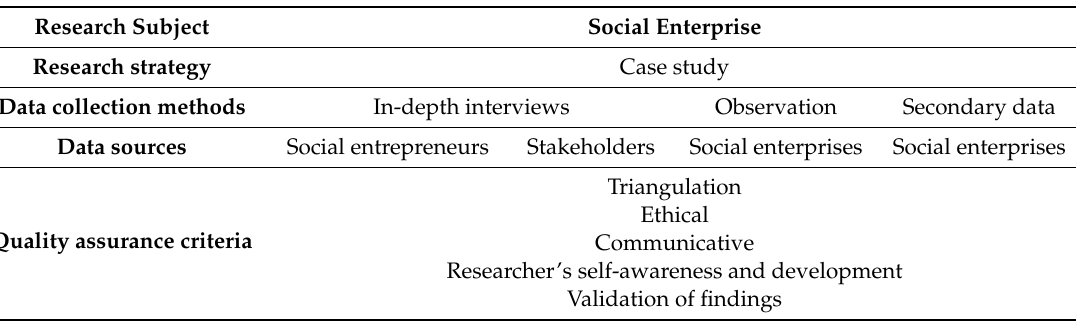
Table 1. Research design of the empirical